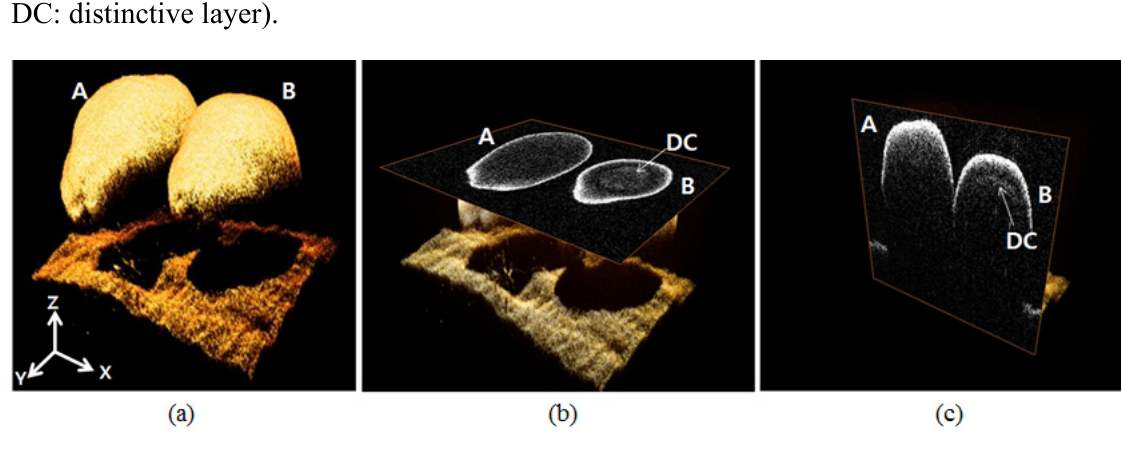
Figure 5. Three dimensional OCT images, ( a ) 3D reconstruction OCT images, ( b ) Enface OCT images, ( c ) Cross-sectional images (A: normal melon seed, B: abnormal melon seed, DC: distinctive